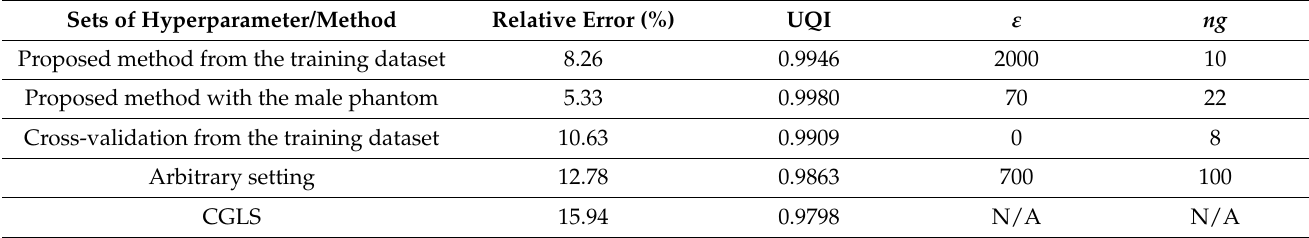
Figure 12. Cross-sectional slices of ( a ) the exact image of male phantom data, ( b ) the reconstruction from directly imple- mented the proposed method on the male phantom data, ( c ) the reconstruction using the hyperparameters obtained from the training stage. Table 5. Relative errors and UQI of image reconstruction results from the male phantom using each set of hyperparameters and the CGLS algorithm